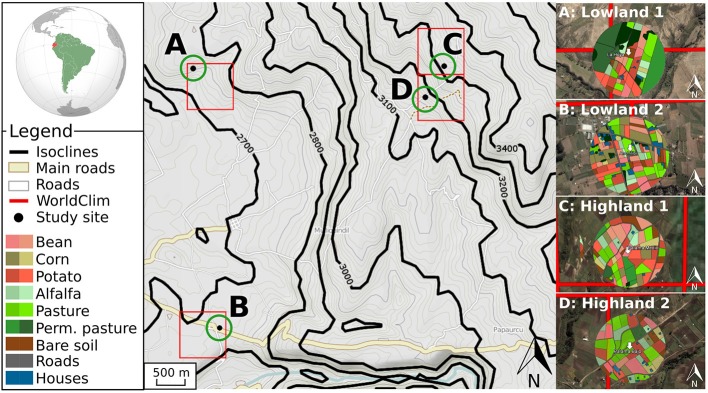
Schematic representation of the three temperature datasets. The global dataset is shown through red lines defining squares of 0.86 km2 corresponding to the WorldClim database. The Weather stations dataset is represented with black points (A–D) corresponding to the coordinates of the data loggers. The Microclimate dataset is schematized with green circles and colored disks (right side of the figure) with a different color for each crop and phenological stages, corresponding to the air temperature inside canopy.